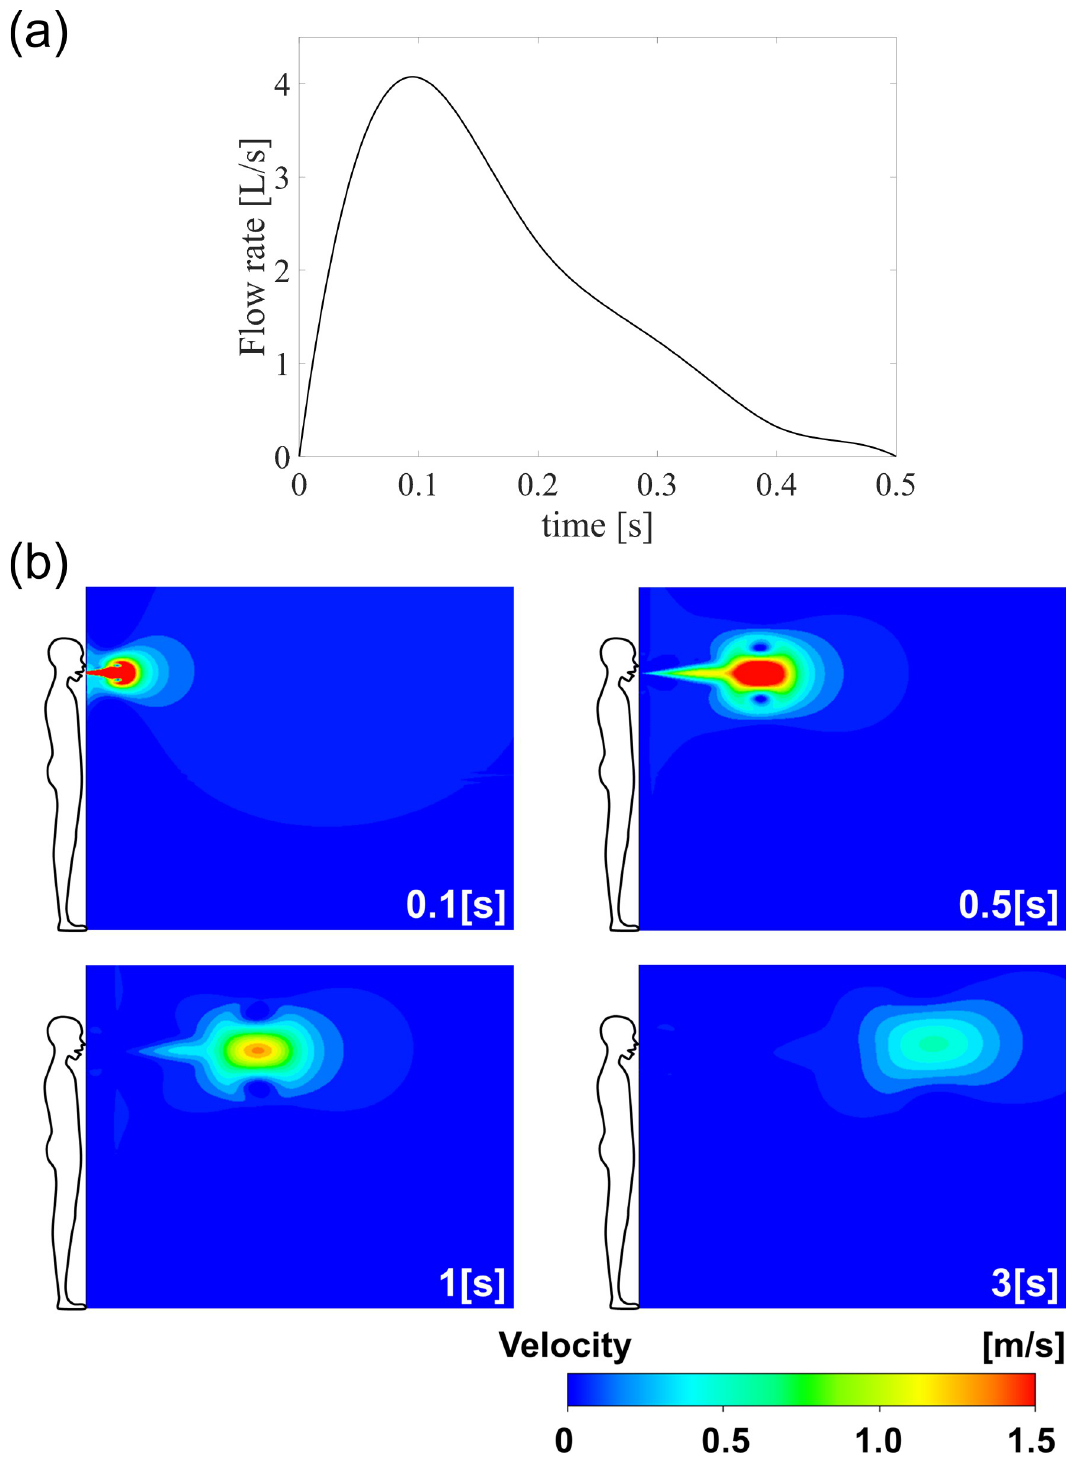
Fig 3. Initial flow rate profile and transient flow field of jet from a cough. (a) Initial flow rate of transient cough event, (b) behaviour of transient cough jet within indoor environment condition of 20˚C and 40% relative humidity.